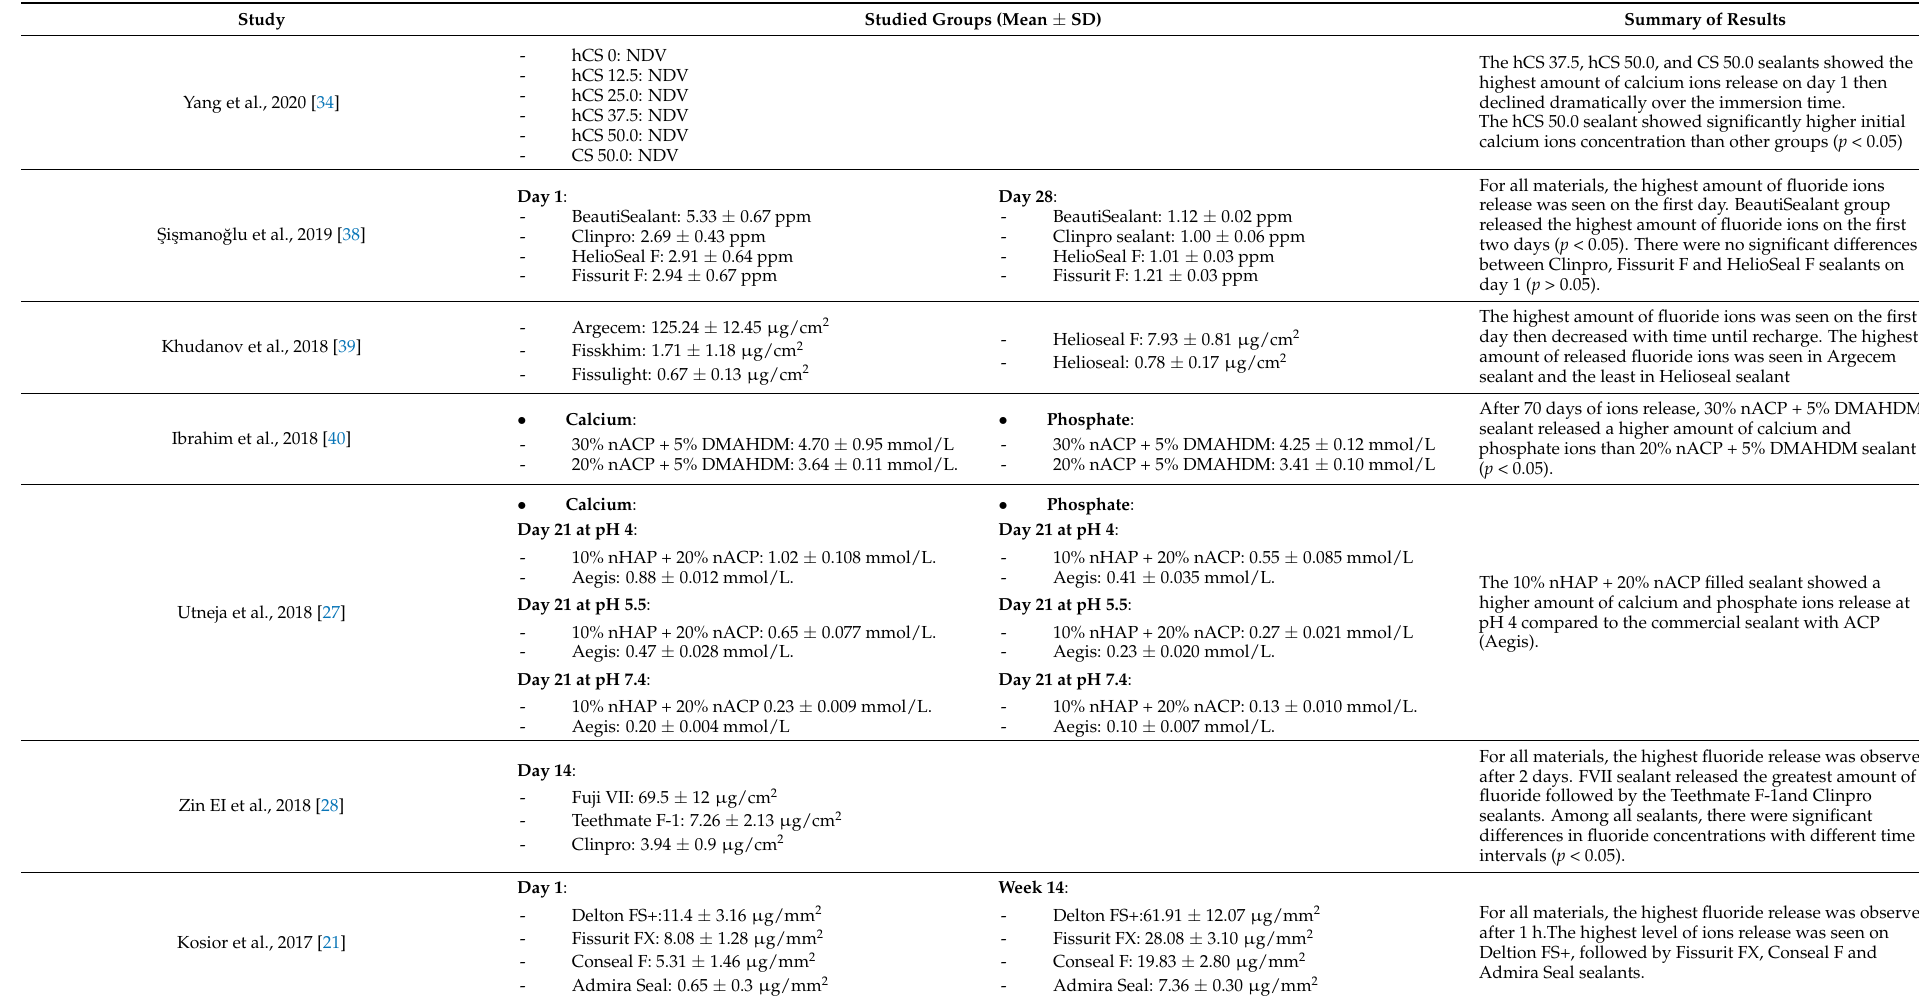
Table 4. Ion release